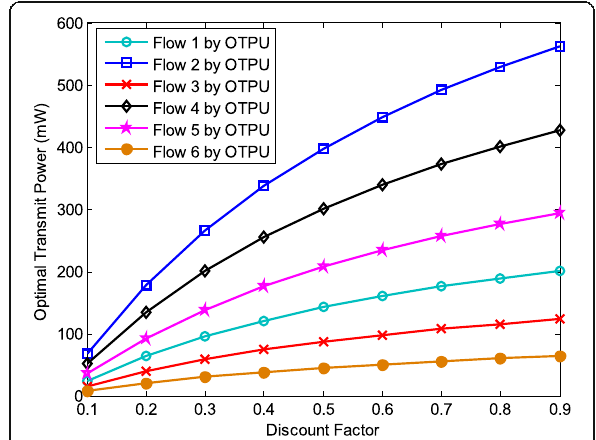
Fig. 9 Optimal transmit power comparison among six per-link flows through our proposed OTPU algorithm under interference